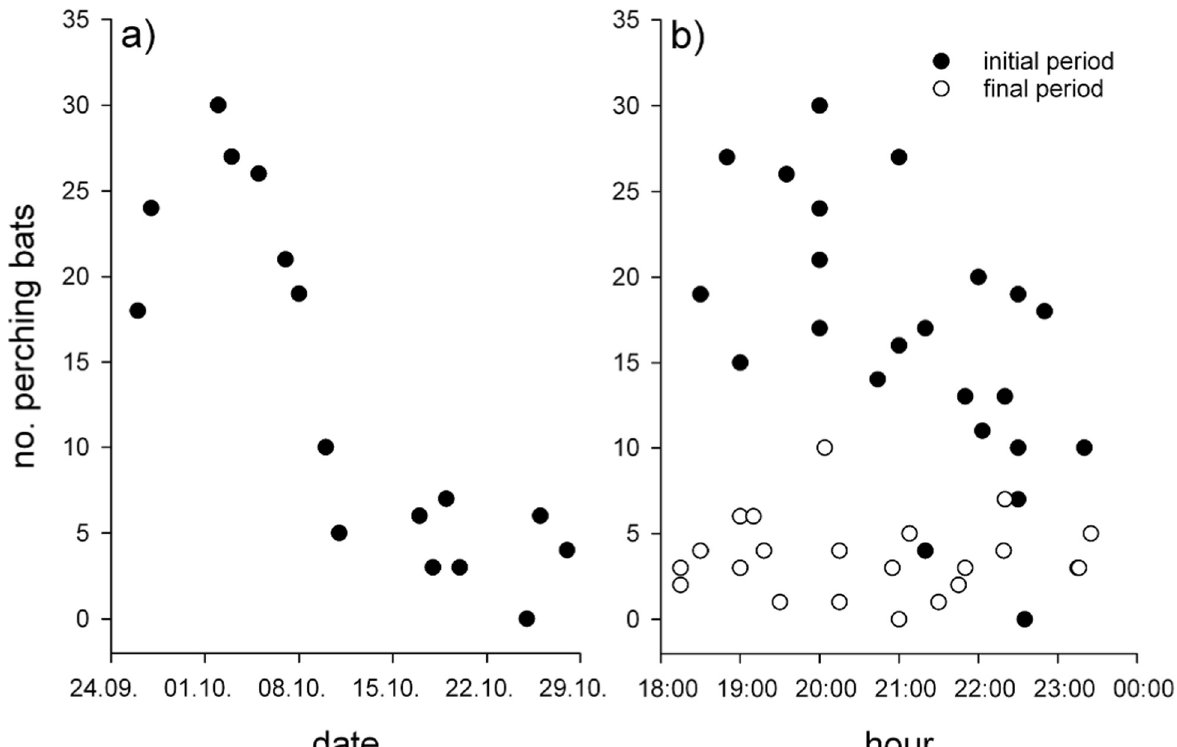
Fig 1. Phenology of a Centurio senex male aggregation. a) Maximum number of perches occupied by male C . senex per night over the entire sampling period. The bats were first observed on September 15 th , 2018. b) Development of the number of perching males over the night. Black dots refer to the first half of the study period until October 10 th , 2018, white dots refer to the second